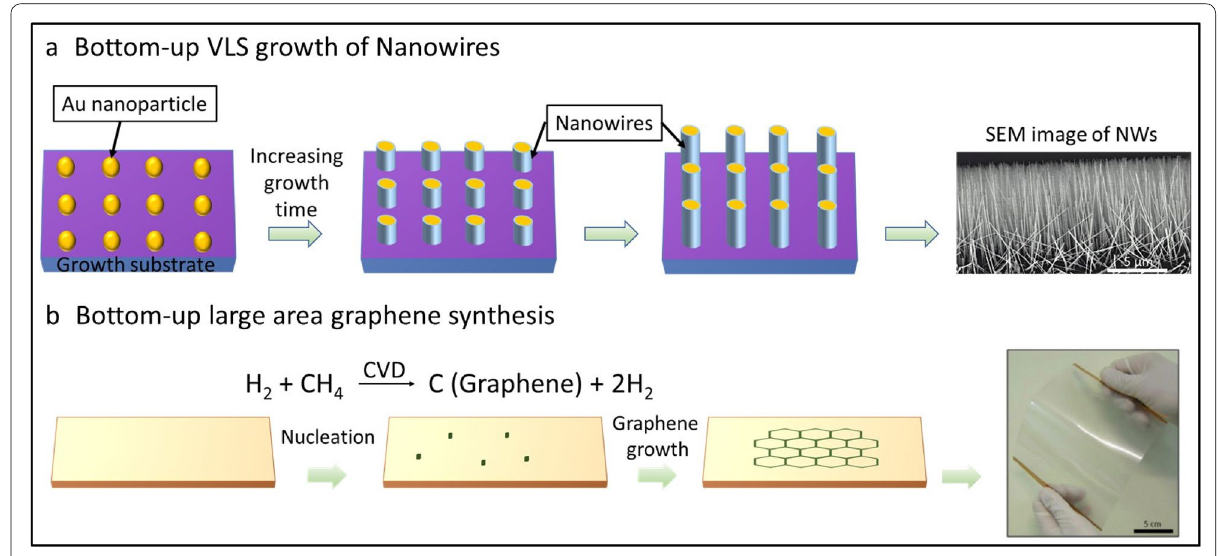
Fig. 5 Schematic representation of the growth of nano scale structures via bottom-up methods: ( a ) VLS growth of nanowires and ( b ) CVD based large area graphene synthesis